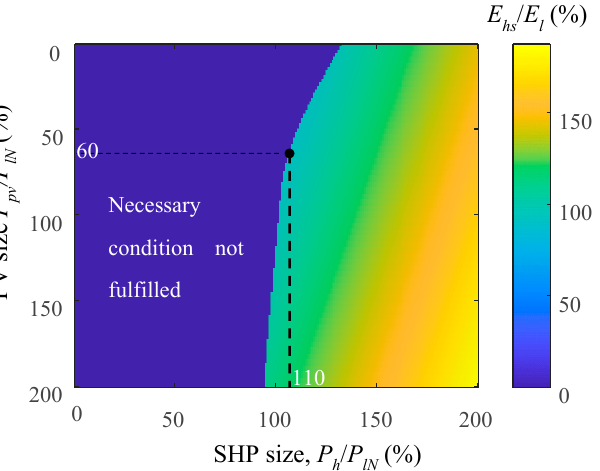
Figure 14. The annual PV/hydro energy as a function of PV/hydro sizes related to the average load energy.